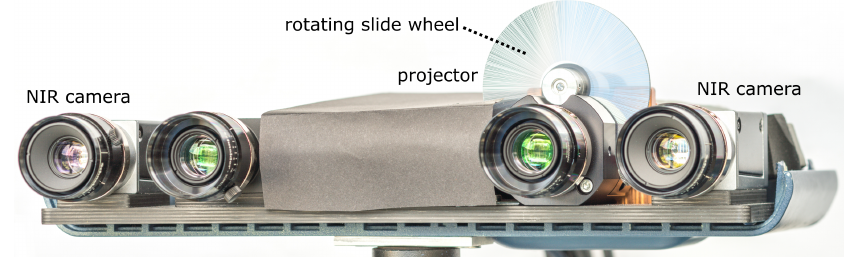
Figure 5. 3D sensor (with removed outer housing) which we used for data recording. From left to right: near infrared (NIR) camera, color camera (not used for this paper), NIR GOBO projector with rotating slide wheel, second NIR camera. The NIR cameras acquire the image sequences for the 3D